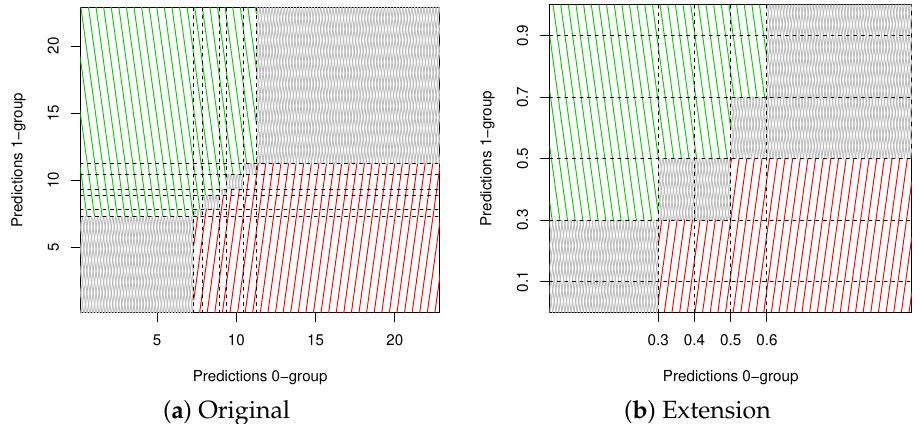
Figure 4. The different regions of the grid in which the concordant pairs (downward dashed region, in green), the discordant pairs (upward dashed region, in red) and incomparable pairs (upward and downward dashed region, in grey) are highlighted. This is done for the original and the extended marginal